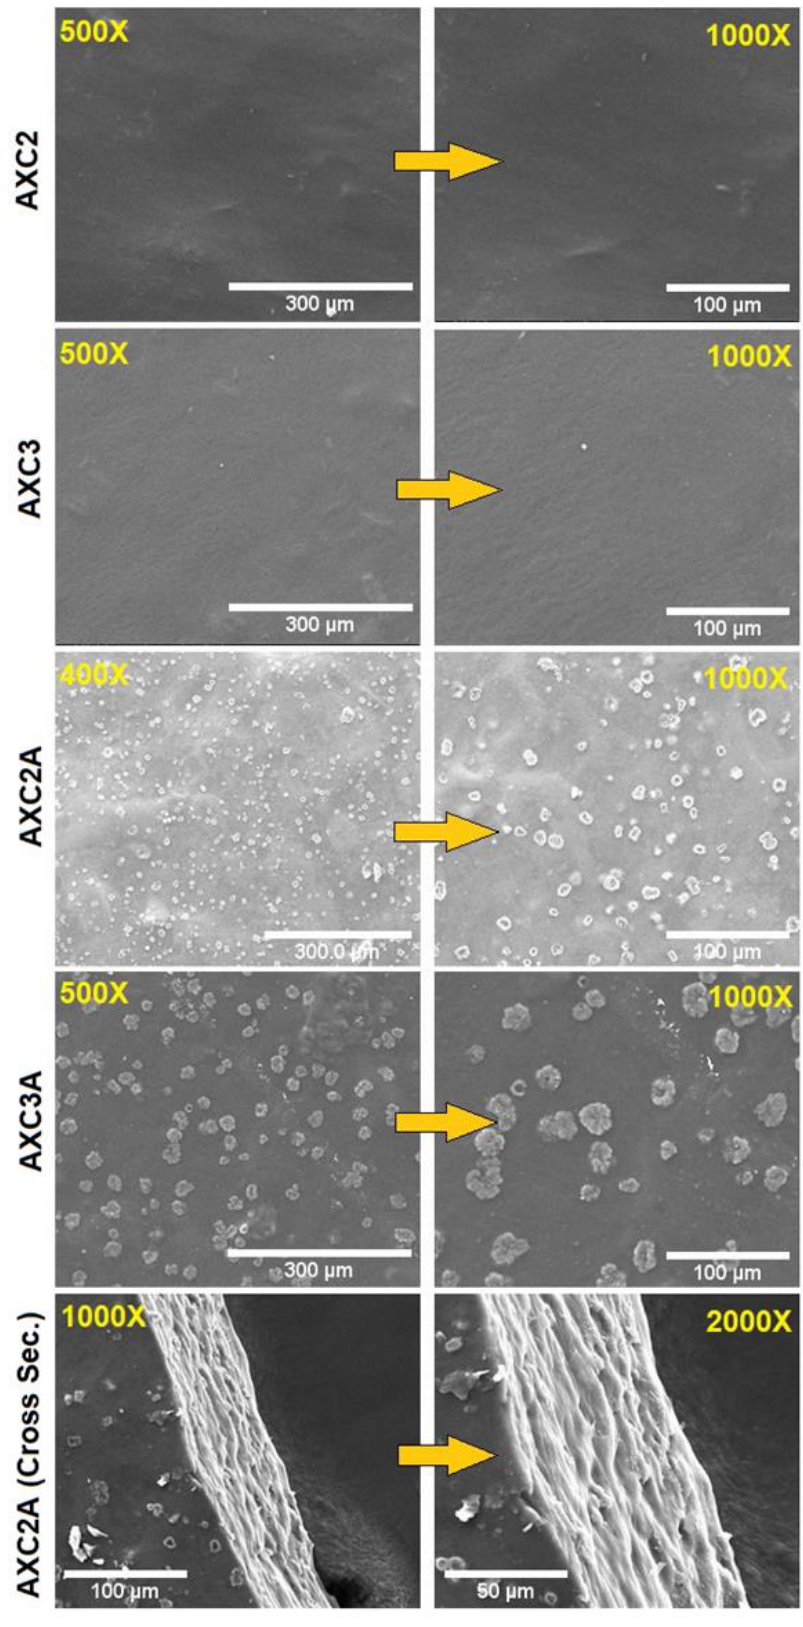
Figure 1. SEM images of the AX-CMC composite films. FTIR-ATR analyses were performed to investigate the possible chemical interac- tions among AX, AMC, GLY, and AMK during AX-CMC film preparation. The FTIR spectra of AX, CMC, AMK, GLY, AXC2 (blank AX-CMC film), and AX2CA are present- ed in Figure 2. The spectrum of AX presents absorbance due to –OH, –CH, –COOH groups and glycosidic linkages at approximately 3375, 2925, 1610, and 925 cm −1 , respec- tively. This spectrum is consistent with the previously extracted AX from PSH [41]. The signature peaks of CMC were observed in its spectrum at 3375 (–OH), 2925 (–CH), 1605